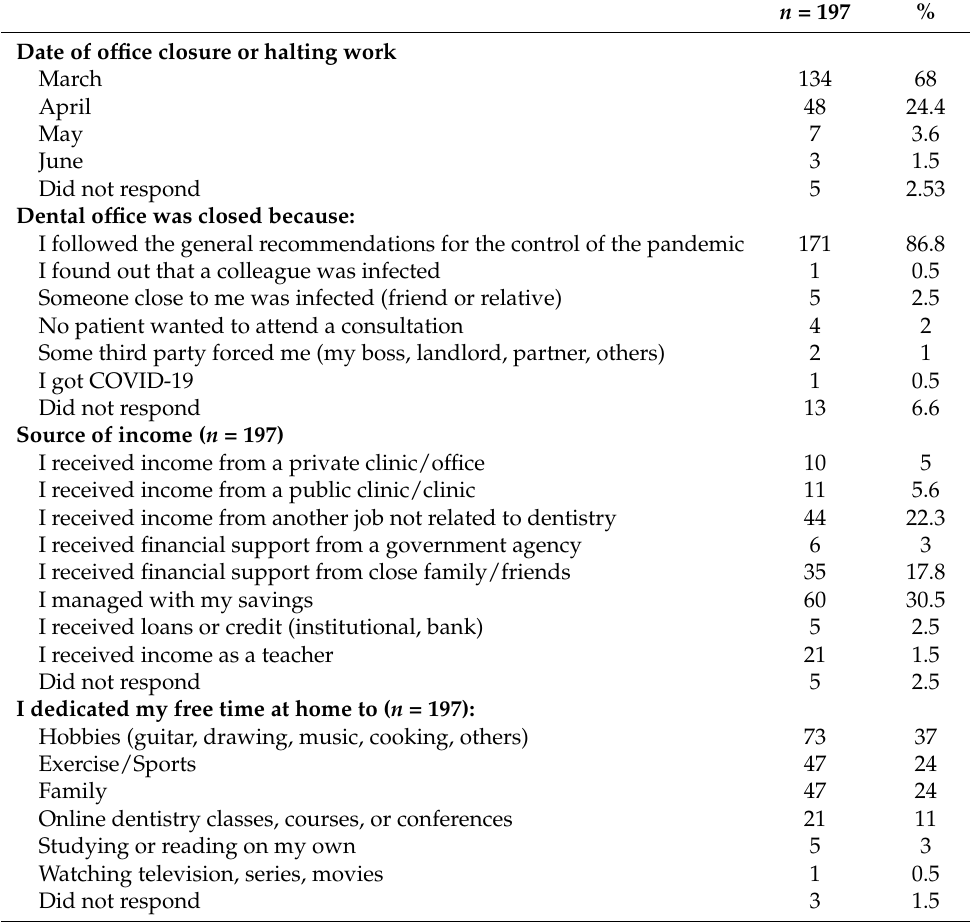
Table 2. Activities of dentists who did not work during the active phase of the